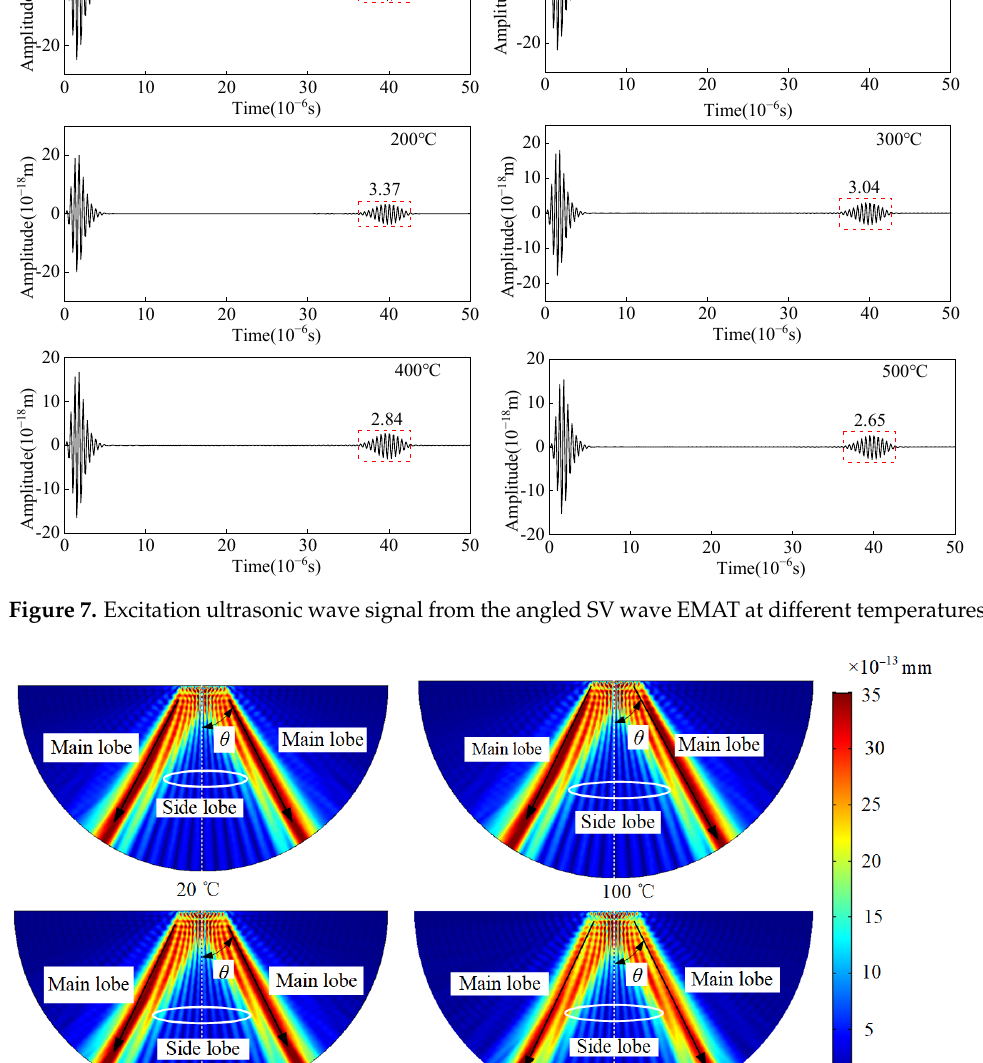
Figure 9. Influence of temperature on ( a ) radiation angle ( b ) main lobe amplitude ( c ) main lobe width ( d ) main-side lobe ratio of the angled SV wave. Changing the elastic modulus of the carbon steel specimen to study the amplitude and flight-of-time of the angled SV wave with temperature, and the ultrasonic wave signal at different temperatures is shown in Figure 10. As the temperature increases, the flight- of-time of the crack-reflected echo increases 3.3 μ s from 20 °C to 500 °C. When the tem- perature increases from 20 °C to 200 °C, the amplitude of the crack-reflected echo increases and gradually decreases with increasing temperature from 200 °C to 500 °C. The main lobe amplitude increases from 20 °C to 200 °C, and gradually decreases with increasing temperature from 200 °C to 500 °C. When the defect is detected using the angled SV wave, the amplitude of the crack-reflected wave obtained shows the same trend as the main lobe amplitude.